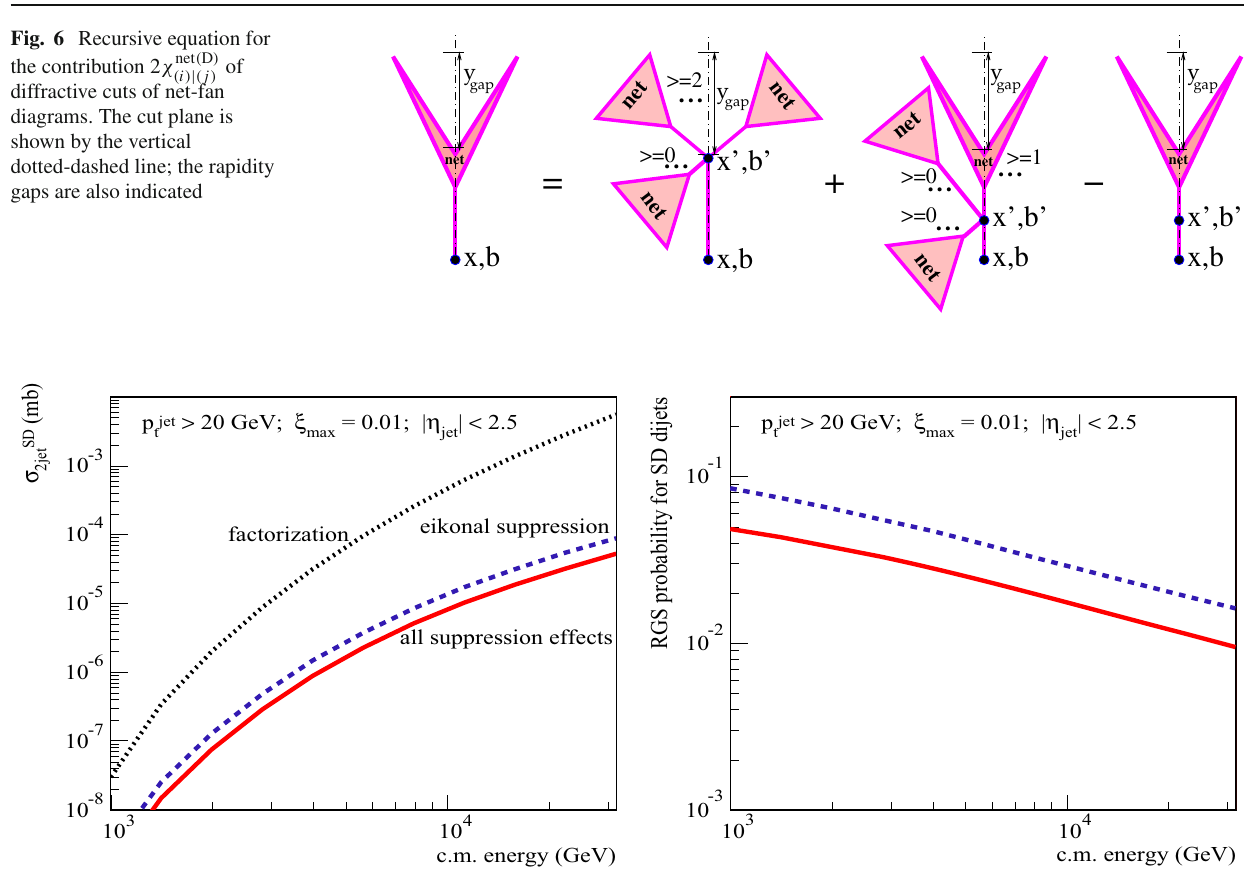
Fig. 7 Left: energy dependence of the calculated single diffractive − SD ( fact ) σ 2jet − SD ( eik ) dijet cross sections: σ 2jet pp (dotted), pp (dashed), and σ 2jet − SD pp (solid). Right: energy dependence of the corresponding RGS